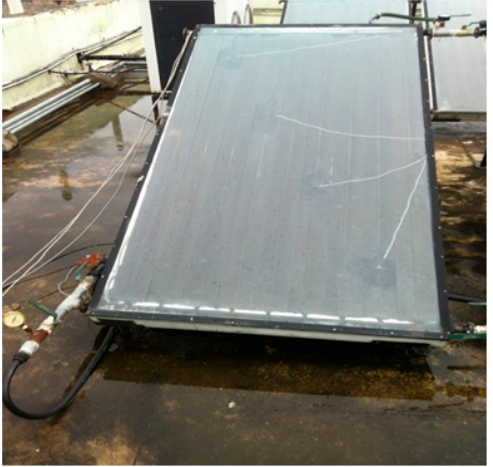
Figure 8. Photograph of thermosyphon solar FPC.